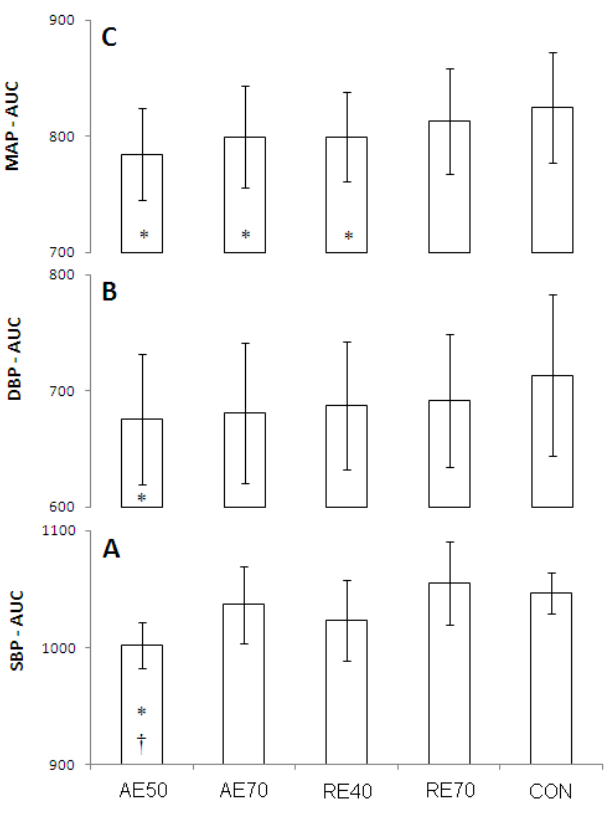
Figure 2. Area under the curve for the systolic blood pressure (A), diastolic blood pressure (B) and mean arterial pressure (C) during the four experimental sessions and the control session over a 24-h period. * p <0.05; significantly different compared with the control session. † p <0.05; significantly different compared with the RE70